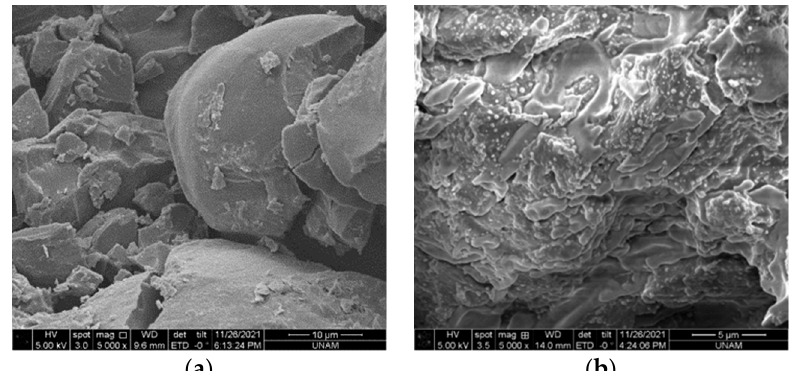
Figure 1. SEM images of PSNC1 ( a ) and PSNC4 ( b ) nanocomposites.